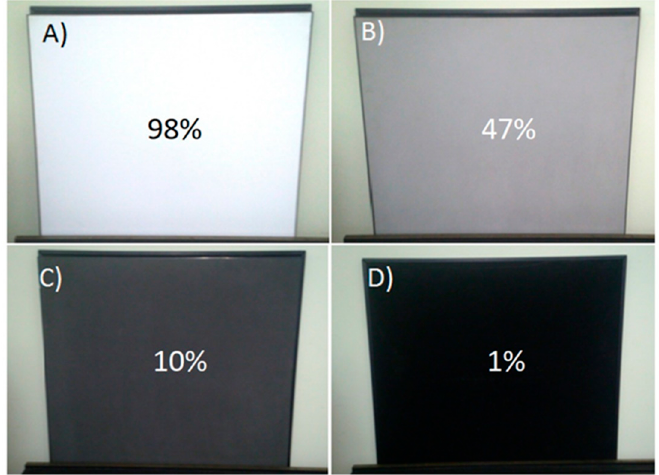
Figure 11. Test targets with calibrated reflectance used in the experiments. Reflectance equals ( A ) 98%, ( B ) 47%, ( C ) 10%, ( D )